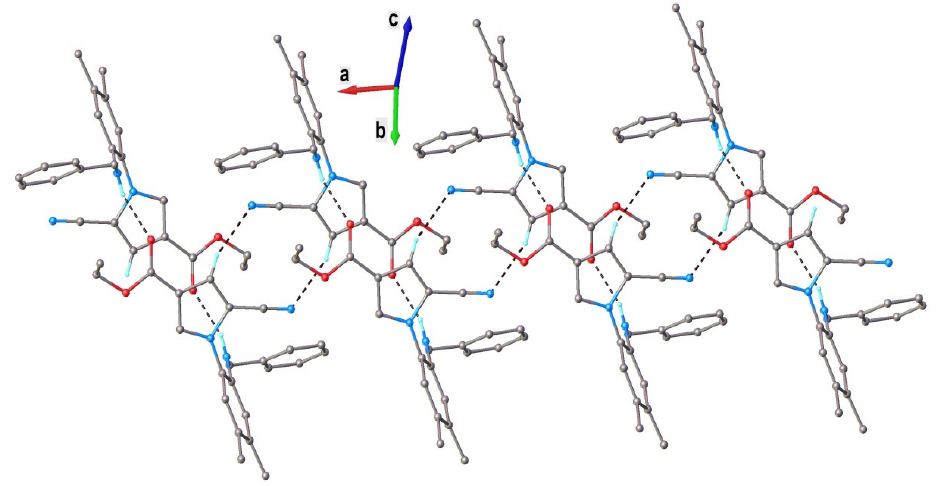
Figure 3. A view of a 1D supramolecular chain in the crystal structure of 4d (for A molecules). Nonrelevant H atoms were omitted. H-bonds parameters: N3-H···O1 [N3-H 0.86 Å, H···O1 2.15 Å, N3···O1(1 − x, − y, 1 − z) 2.873(3) Å, ∠ N3HO1 141.3°]; C18-H···N1 [C18-H 0.93 Å, H···N1 2.59 Å, C18···N1( − x, − y, 1 − z) 3.384(4) Å, ∠ N3HO1 144.0°].